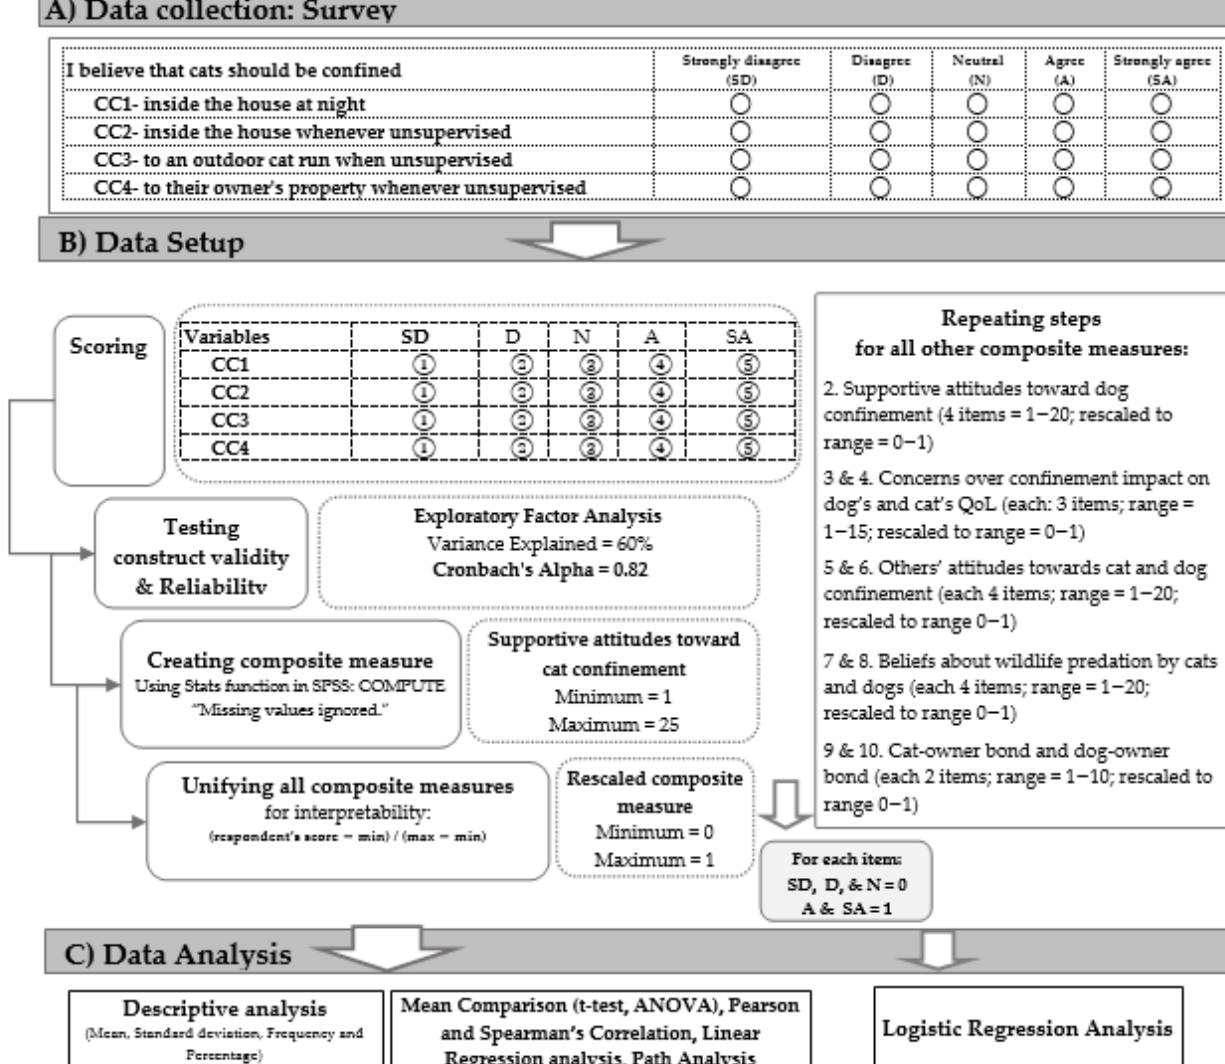
Figure 1. Conceptual flowchart of survey data setup and analysis: ( A ) data collection using an online survey with 5 scale items about cat and dog confinement; ( B ) data cleaning, scoring, combining, validating, and creating composite scales for further statistical analysis; ( C ) data analysis including descriptive, univariable and multivariable analysis methods.